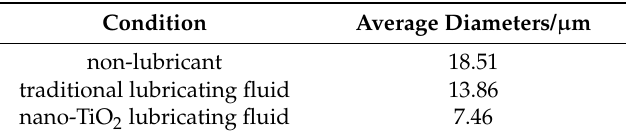
Table 4. The average diameters of the grains.